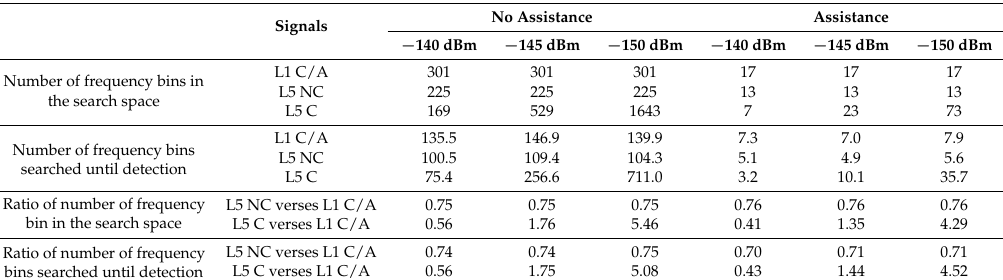
Table 13. Theoretical and average of the measured number of frequency bins and their ratio between L5 and L1.